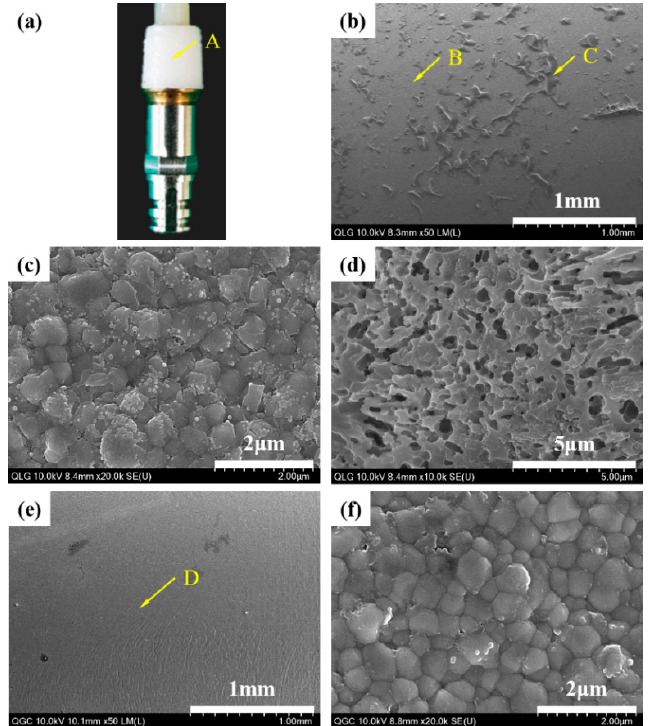
Figure 10. Photographic ( a ) and HR FE-SEM images ( b – d ) of the zirconia ceramic abutment; ( b ) the magnification of point A for the MLG group: Inhomogeneous pattern of fracture surface; ( c ) the magnification of point B: Adhesive fracture occurred at the interface with liner; ( d ) the magnification of point C: Cohesive fracture occurred through the liner; ( e ) the magnification of point A for the MGC group: Homogeneous pattern of fracture surface; ( f ) the magnification of point D: Zirconia crystals indicating that an adhesive fracture occurred at the interface with resin cement.